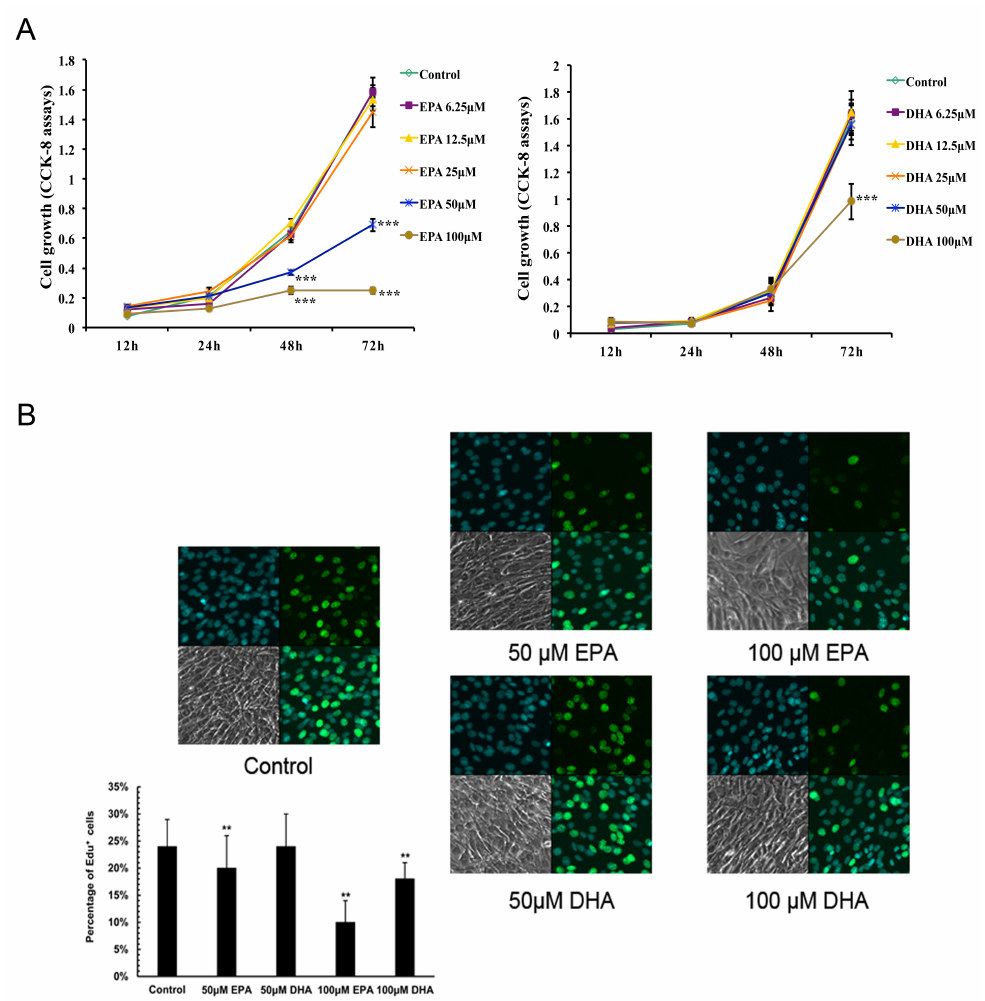
Figure 1. The effects of eicosapentaenoic acid (EPA) and docosahexaenoic acid (DHA) on the viability and proliferation of C2C12 myoblasts. C2C12 myoblasts were treated with EPA or DHA at different concentrations. ( A ) The CCK-8 assay was performed to measure cell viability at 12, 24, 48 and 72 h after EPA or DHA treatment. The X axis represents time of treatment. The Y axis represents the absorbance determined at 450 nm. The data represent the mean ± S.D. from three independent experiments performed in duplicate. Different from control, *** p < 0.001. ( B ) C2C12 myoblasts were treated with EPA or DHA at concentrations of 50 or 100 µ M. Cells were stained with Edu. Original magnifications 600 × . The percentage of Edu + C2C12 cells was quantified. The data represent the mean ± S.D. ( n = 6). Different from control, ** p <